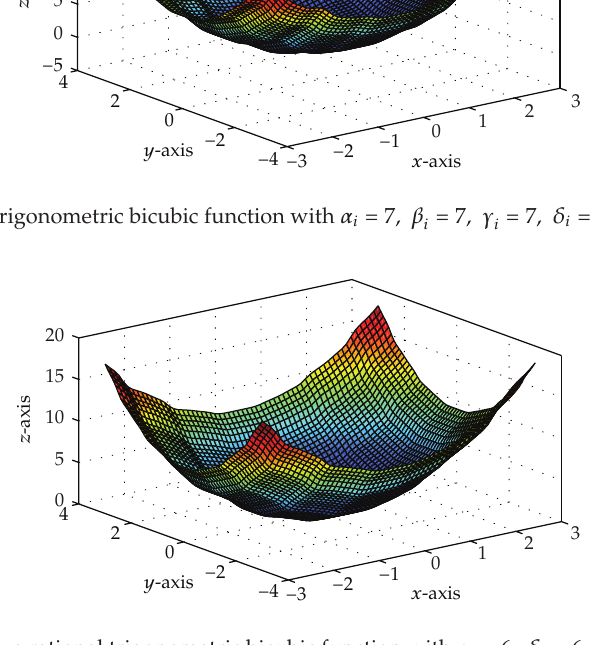
Figure 8: C 1 positive rational trigonometric bicubic function with α i (cid:8) 6 , δ i (cid:8) 6 , (cid:28) α j (cid:8) 6 , and